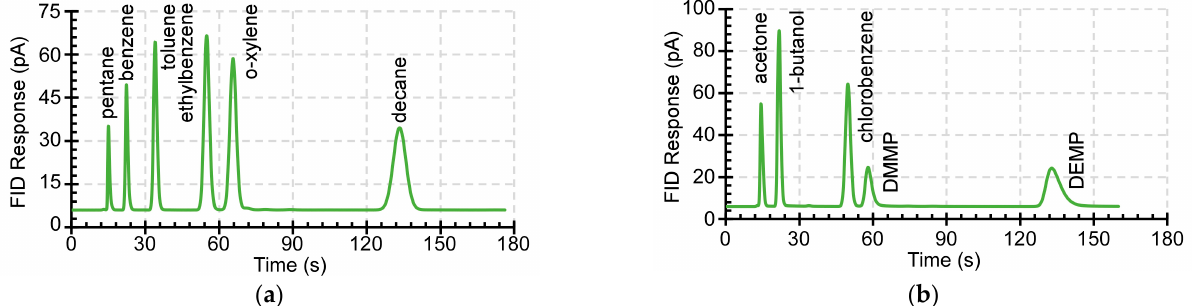
Figure 14. ( a ) The chromatogram of non-polar chemical analytes in Case 3. ( b ) The chromatogram of polar chemical analytes in Case 3.